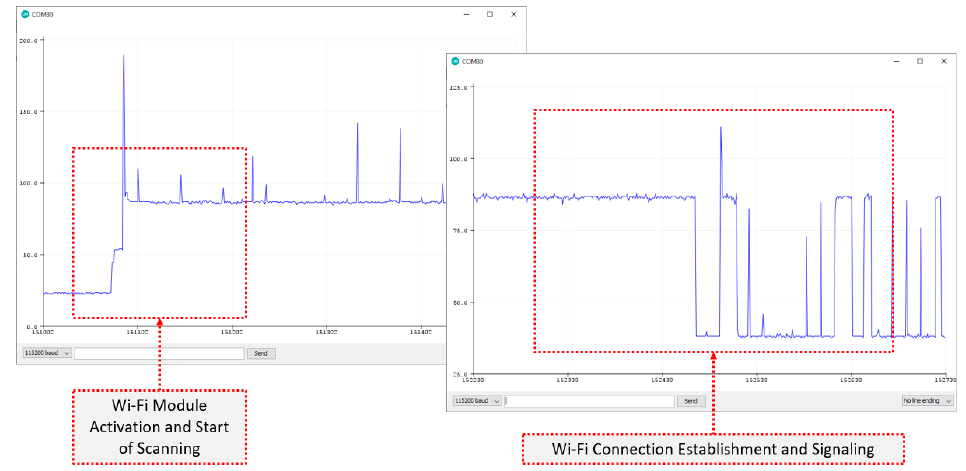
Figure 9. Short time dynamics of the mandatory scanning and connection establishment stages, following the activation of the Wi-Fi radio module that smart sensors were equipped with.